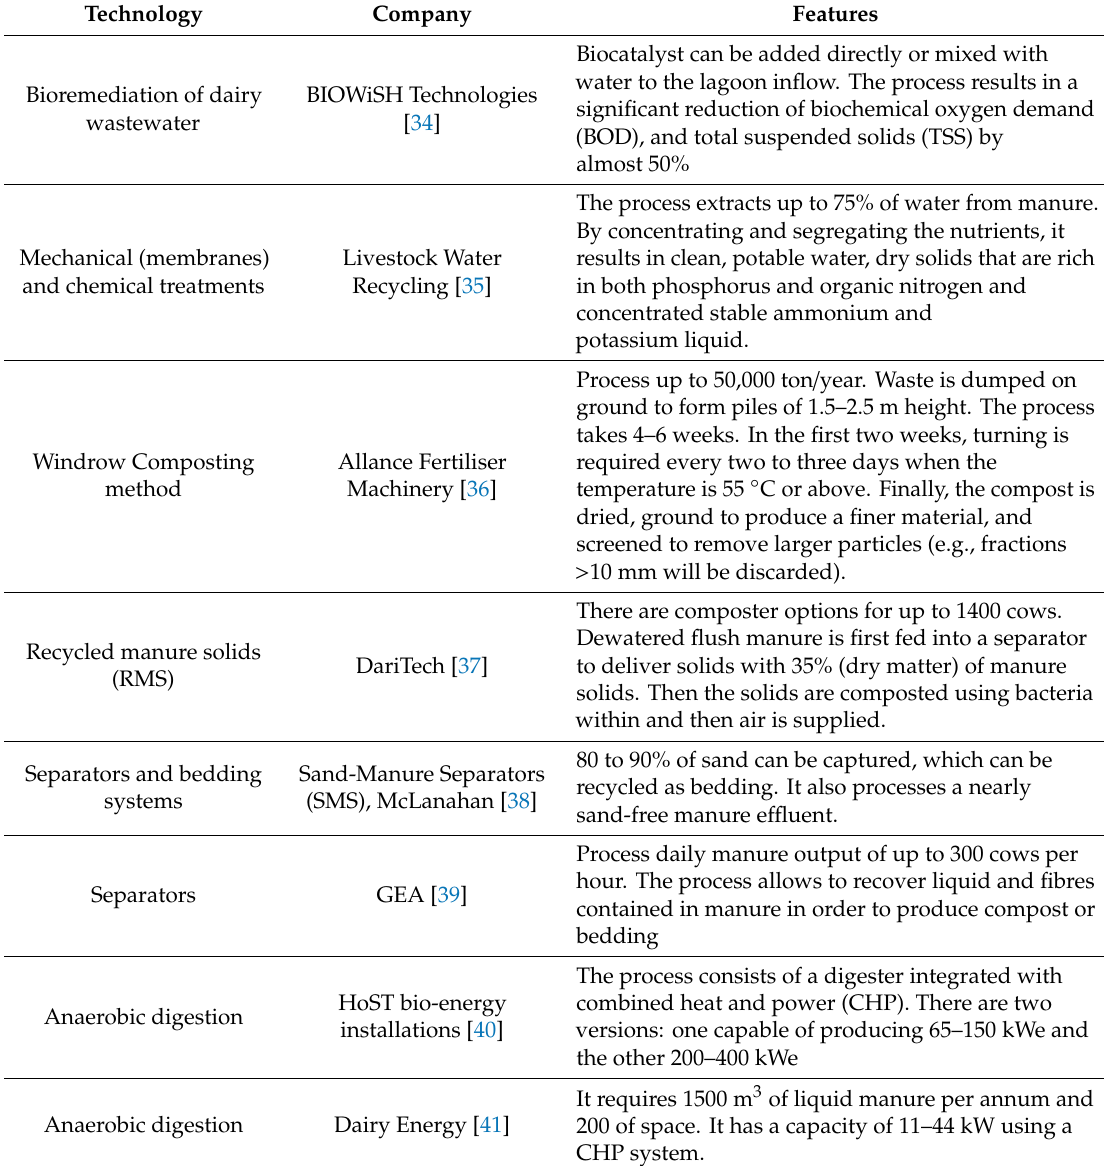
Table 4. Commercial technologies to treat slurries and manure from cattle